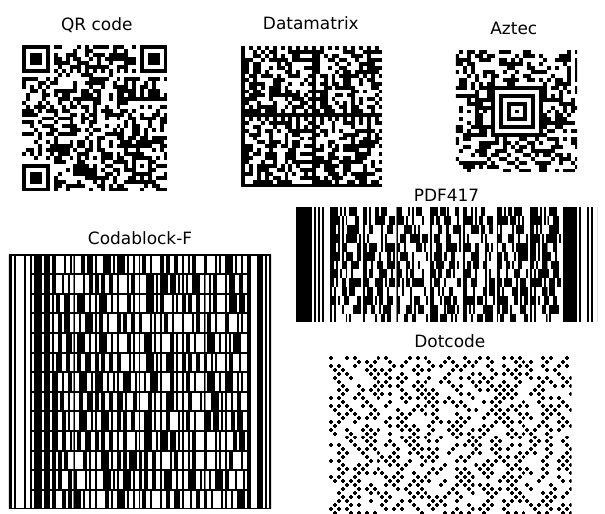
Figure 2. Exemplary 2D barcodes containing the same text comprising 89